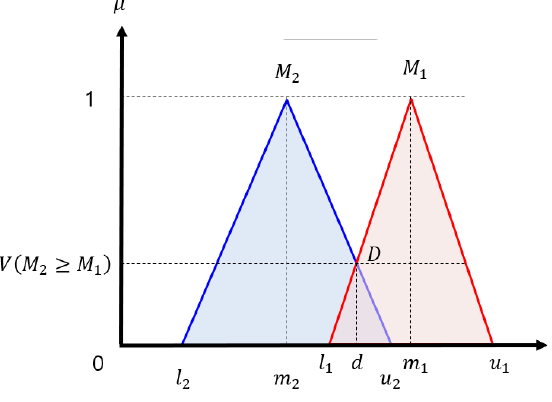
Figure 1. The intersection between M 1 and M 2